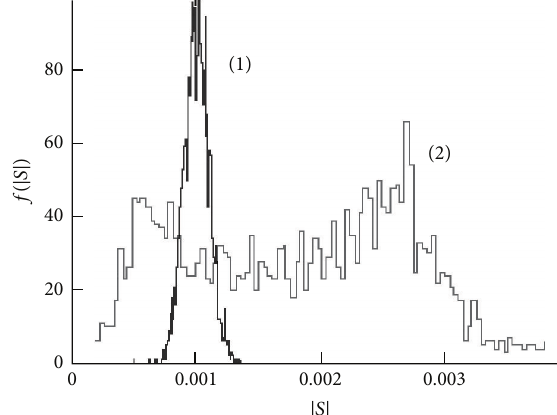
Figure 6: Initial (1) and final (2) weight distributions of the function | in the absence of an external shear |𝑆 𝑖,𝑗